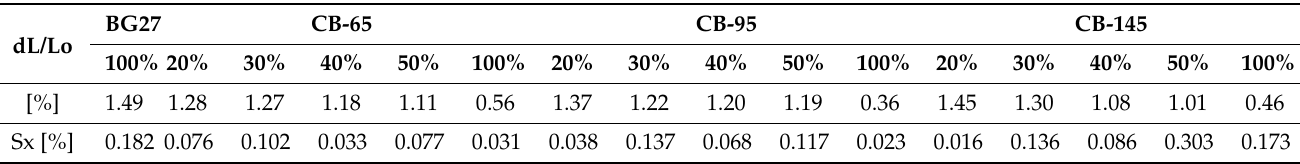
Table 3. Thermal expansion results of hybrid mixtures and reference pure